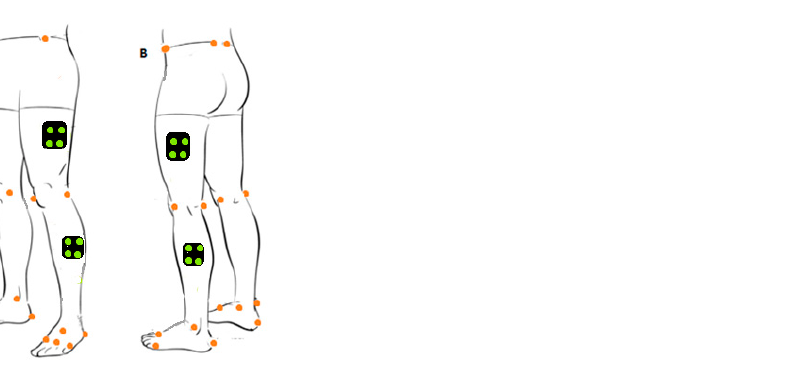
Figure 1. Positioning of the retroreflective markers attached to the subjects. Adapted from [40]: ( A ) anterior view; ( B ) posterior view.